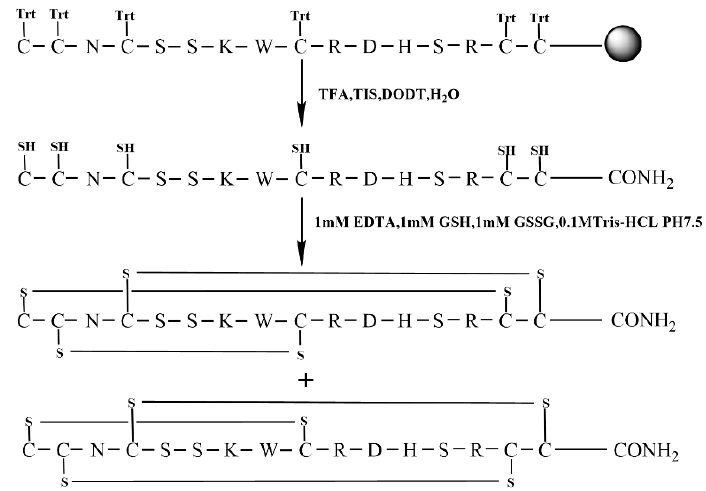
Figure 2. Free random oxidation strategy of KIIIA (S cheme 1